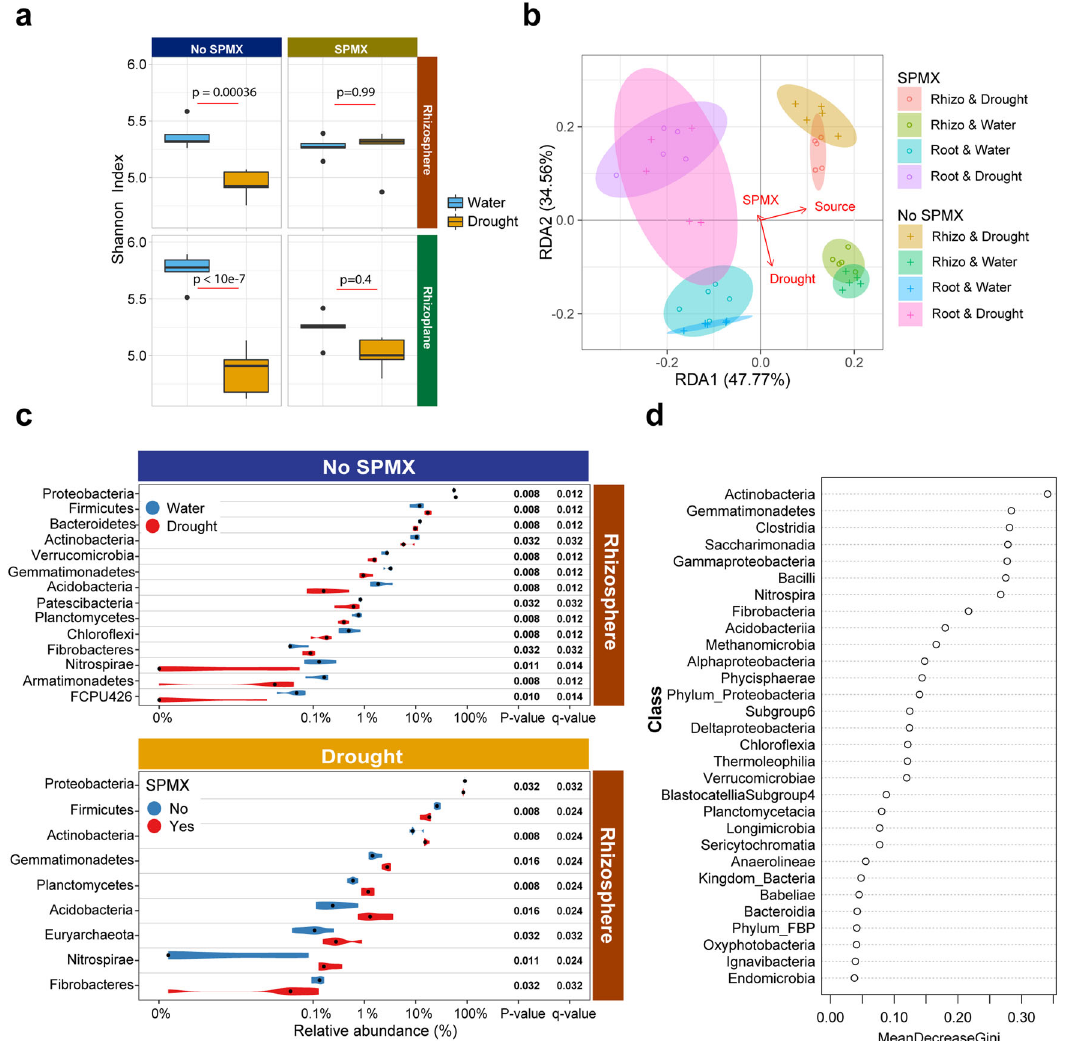
Fig. 5 The in fl uences of drought stress and SPMX on root microbial diversity and composition. a Boxplots of Shannon ’ s Diversity in drought (yellow) and water (blue) for two soil compartments (rhizosphere/rhizoplane) with and without SPMX inoculation. P > 0.05 indicates that drought treatment groups were not signi fi cantly different from the respective watering control group by one-way analysis of variance (ANOVA). b Redundancy analysis (RDA) plot for all soil samples generated using the Bray – Curtis distance; samples are colored for each combination of soil compartments (rhizosphere/rhizoplane), inoculation treatment (SPMX/non-SPMX) and water treatment (drought/water). Control = No SPMX, Rhizo = Rhizosphere, Root = Rhizoplane. c All the signi fi cantly differential bacterial phyla at RA in the rhizosphere between drought (red) and well-watered (blue) conditions without SPMX inoculation (upper chart); All the signi fi cantly differential bacterial phyla in the rhizosphere when inoculated with SPMX (red), compare to that inoculated with no SPMX (blue) under drought; Only statistically signi fi cant values (FDR adjusted P < 0.05, Wilcoxon rank-sum test) were shown. d The importance of taxa at class level under drought by random forest. Mean decrease in Gini was used to evaluate the importance level of bacterial classes affected by SPMX in the rhizosphere under drought. Data based on fi ve samples ( n = 5) collected in each treated lower than that under well-watered conditions (Fig. 5a). This the endpoint of 21 dpi before re-watering (Fig. 1a), and microbial suggested that SPMX might protect root-associated microbial alpha-diversity and beta-diversity were analyzed. Different soil diversity from drought. compartments (rhizosphere/rhizoplane/bulk soil) explained the Next, we performed RDA analysis and quanti fi ed the in fl uence main variation in microbial compositions (Supplementary Fig. 3), of three variables including SPMX, drought and soil compart- the bulk, rhizosphere and rhizoplane soil samples all had ments on microbial diversity through partition of sum of signi fi cantly different microbial compositions compared one to variations. As shown in the RDA plot (Fig. 5b), the microbial beta another (FDR adjusted P = 0.001, 0.001, and 0.001, respectively). diversity with the eight combinations of conditions differed Drought stress signi fi cantly decreased the microbial alpha signi fi cantly between each other (Pairwise PERMANOVA, FDR diversity of bacterial communities in two soil compartments adjusted P = 0.001 for all the comparisons). Besides, SPMX, (rhizosphere/rhizoplane) in the non-SPMX control (Fig. 5a), drought and soil compartments shown in the RDA plot consistent with recent studies 12 . However, in the presence of signi fi cantly in fl uenced microbiome compositions (Permutation SPMX, drought did not signi fi cantly lower the microbial diversity test, FDR adjusted P = 0.001, 0.001, and 0.001, respectively) and in both of the two root-associated communities, although the had successively larger effects (adjusted R 2 = 2.1%, 6.85%, and mean of diversity in the rhizoplane under drought was slightly